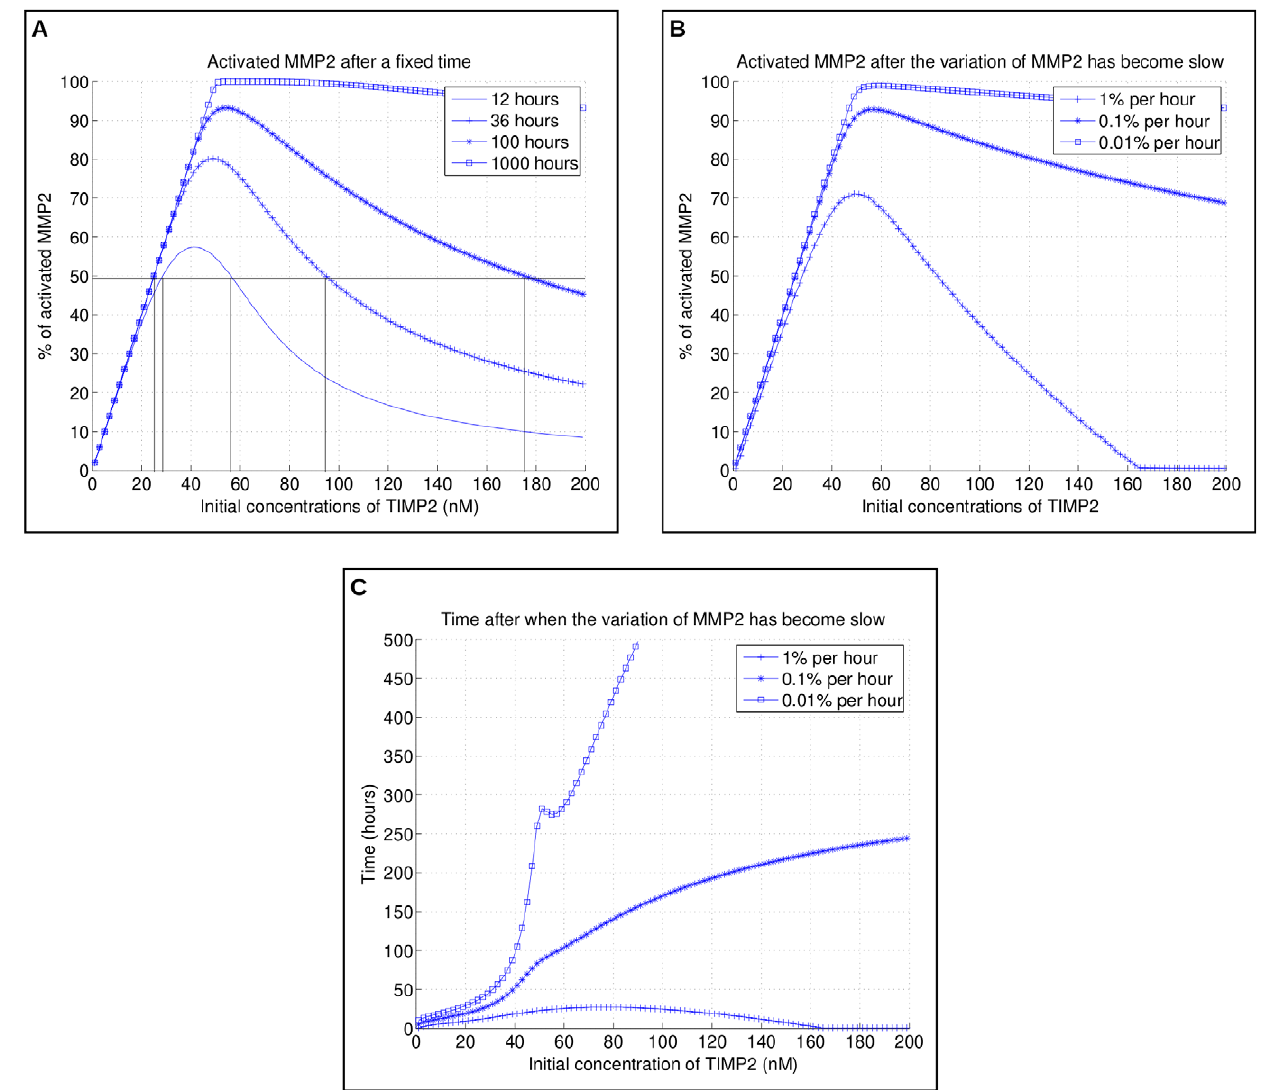
Figure 3. Profile of second enzyme (MMP2) production. We focus here on the activation cascade of pro-MMP2 enzyme, i.e., we exclude shedding and collagen degradation from the model. The initial concentrations of MMP-MT1 is 60 nM and initial pro-MMP2 is 50 nM, which explains the qualitative switch in C for initial TIMP2 greater than 50 nm. A Activated pro-MMP2 in percentage of initial quantity after different fixed times - the curve corresponding to 12 hours reproduces a result from [23]. The asymptotic behavior for times going to ? is, as suggested by the curve corresponding to 1000 hours, a linear activation from 0 to 50 nM and a plateau at 100 % activation for initial TIMP2 § 50 nM. B Activated MMP2 after the variation of MMP2 has reached different low rates. For initial concentration of TIMP2 § 160 nM, the activation rate is never above 1% , hence the percentage is 0. C Time after when the variation of MMP2 has reached the different low rates. The non-monotonic behavior for 0 : 01% per hour above 50 nM suggests there is an optimum value for which activation is eventually (asymptotically) complete while the speed of the process at its beginning is maximized.